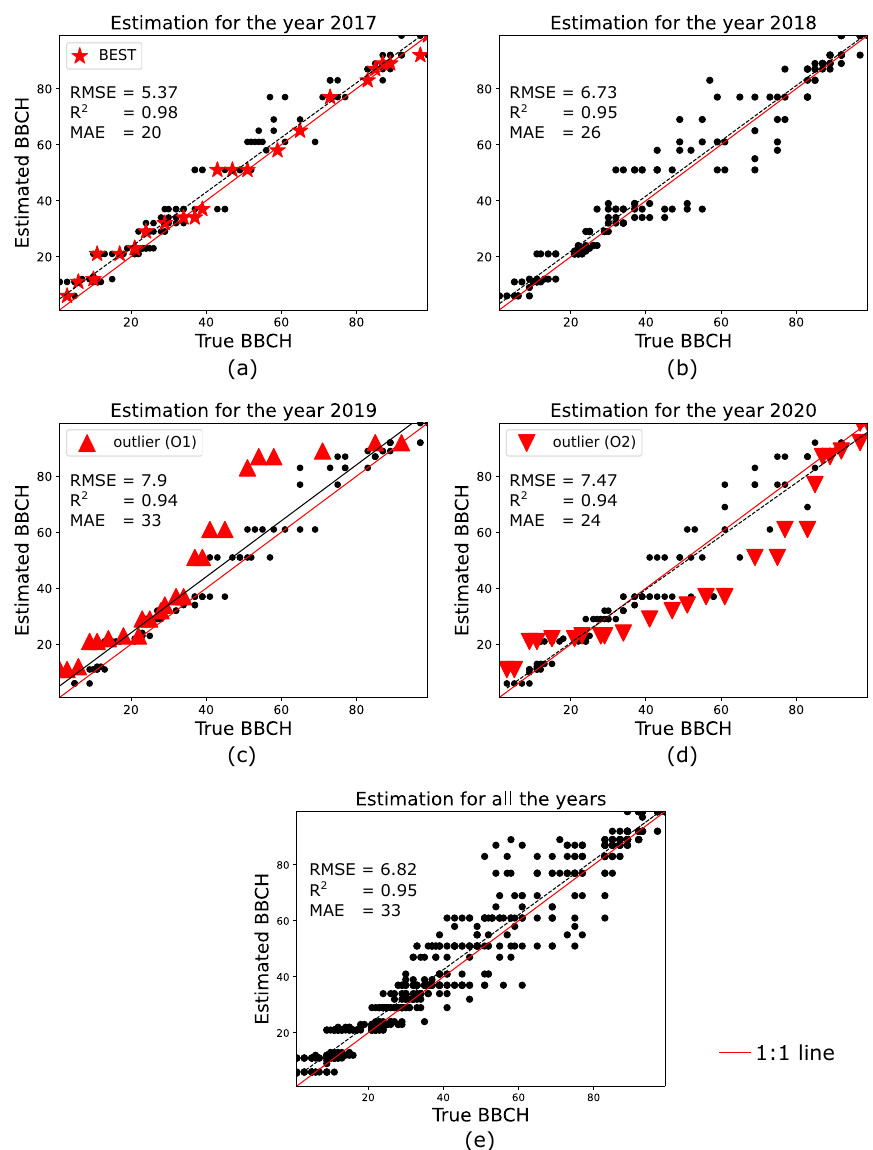
Figure 5. Validation of the estimated phenology for all the experiments, ( a – d ) estimation performance for the years 2017–2020; ( e ) estimation performance combining the results from all the